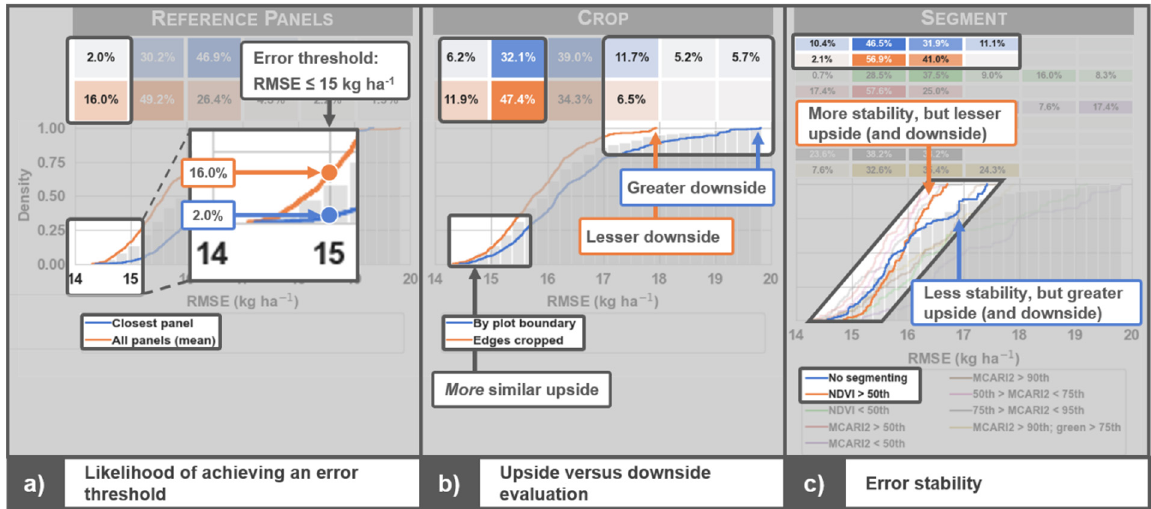
Figure 8. The three key characteristics revealed by empirical cumulative density function (ECDF) plots for evaluating the suitability of image processing scenarios. In the figure labels, upside and downside refer to the potential for low and high root mean square error (RMSE) values, respectively, and stability refers to the consistency in RMSE values across workflow scenarios for each processing scenario.